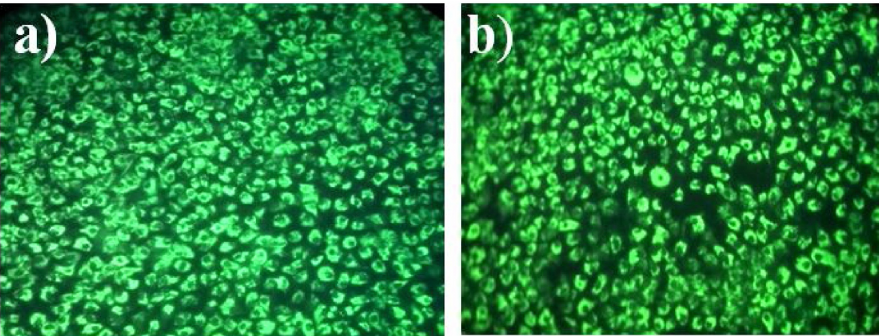
Figure 9. Biocompatibility of HEK-239 cells with AuNPs under fluorescence microscope evidenced by Trypan blue exclusion and AO/EB staining. ( a ) Control cells appear green with no evidence of cell death. ( b ) Cells treated with AuNPs (100 µ g/mL) appear similar to control cells. Reprinted